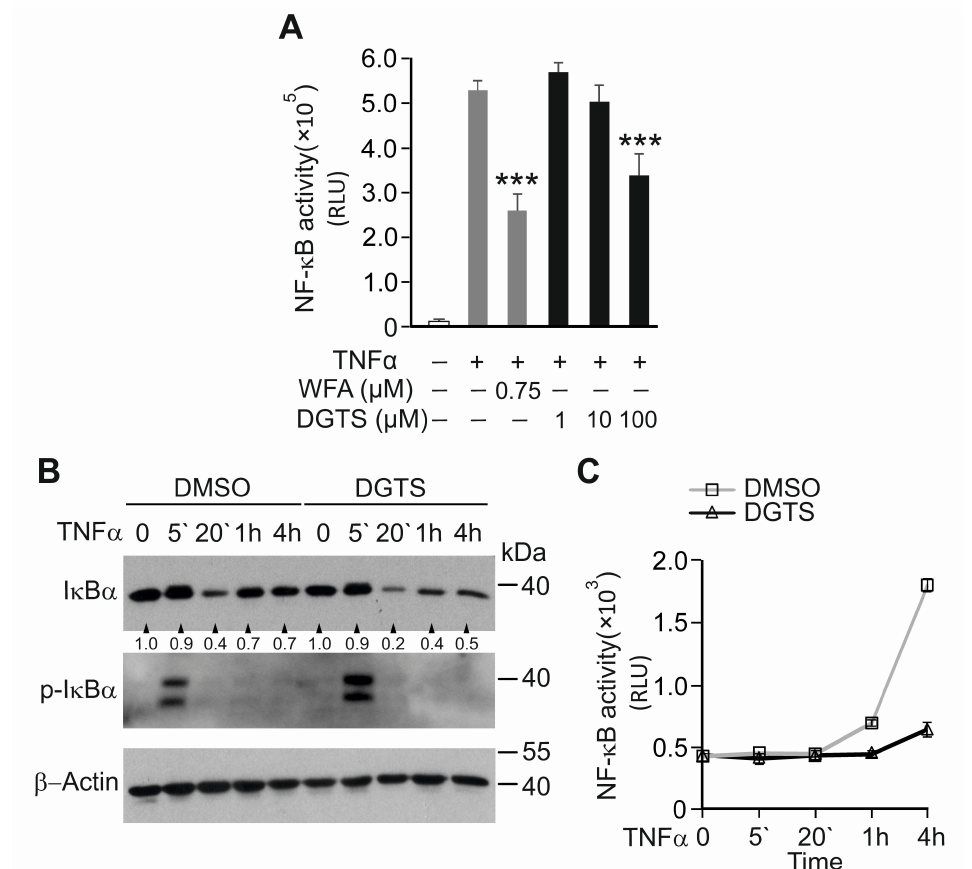
(Figure 8A). DGTS significantly reduced NF- κ B-luciferase activity in the TNF α -stimulated HaCaT cells at a concentration of 100 µ M without compromising cell viability. Next, we tested whether DGTS could reiterate the effect of NAE_2022C on the I κ B α degradation induced by TNF α . As shown in Figure 8B,C, DGTS inhibited an NF- κ B-dependent increase in luciferase activity, observed already after 1 h of TNF α stimulation, but did not prevent the phosphorylation and degradation of I κ B α . Consistent with the inhibition of NF- κ B, the re-synthesis of I κ B α at the late time points of TNF α stimulation was markedly repressed by DGTS. These findings suggest that DGTS likely affects NF- κ B activation downstream of the IKK complex, or through indirect inhibitory mechanisms. Indeed, we showed that, in contrast to NAE_2022C or its active fraction (F7 + F8), DGTS alone did not inhibit the activity of IKK β or the phosphorylation of the I κ B α protein in the in vitro kinase assay (Figure S2). Thus, we identified DGTS (32:0) as an active component of NAE_2022C with anti-inflammatory activity, excluding its direct role in the inhibition of the IKK complex by NAE_2022C.